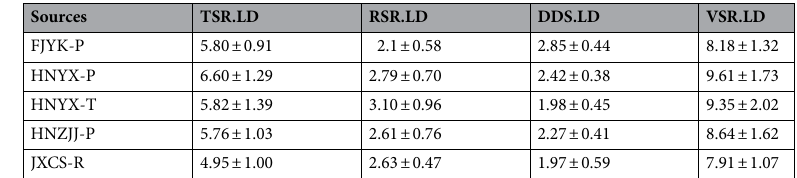
Table 2. The statistical analysis of shrinkage (all-dry ) of Chinese fir. Data are means ± SE. TSR.LD Tangential shrinkage rate of all-dry density, RSR.LD Radial shrinkage rate of all-dry density, DDS.LD Difference dry shrinkage of all-dry density, VSR.LD Volume shrinkage rate of all-dry density.